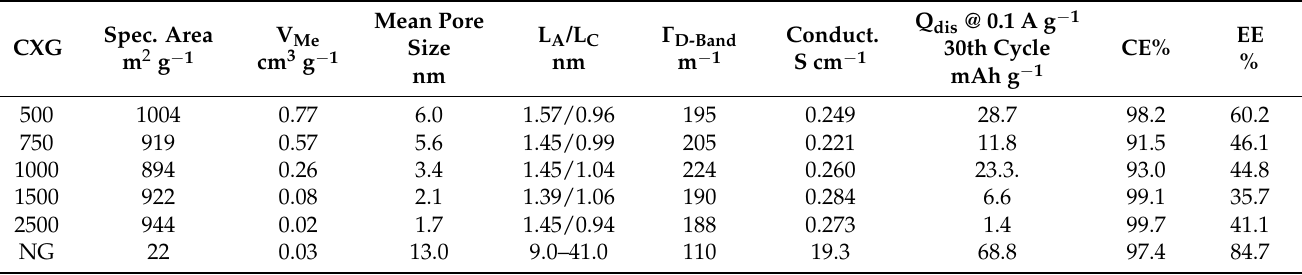
Table 3. Summary of relevant textural properties of synthesized CXGs and natural graphite tested in AIB cell with corresponding performance values at 0.1 A g − 1